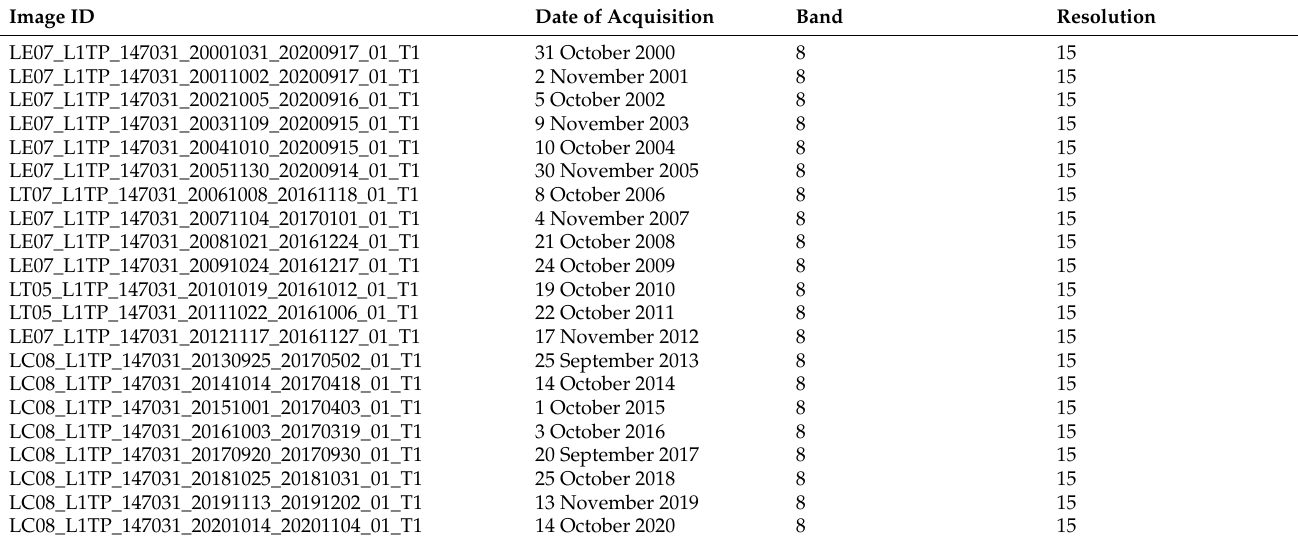
Table 1. The satellite data used in this